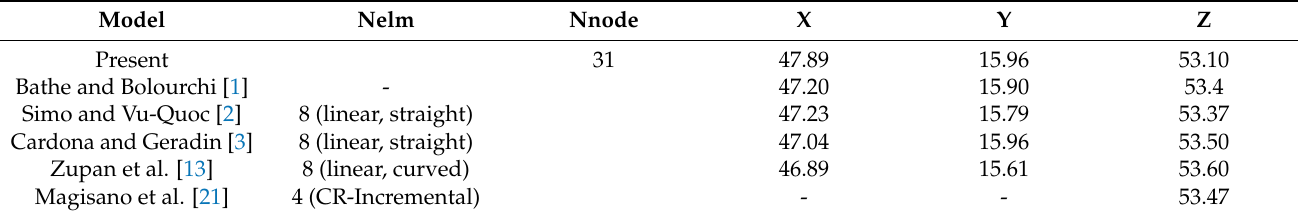
Figure 9. Load versus displacement curves of tip for the cantilever curved beam under an end force. Table 1. Free-end position of the cantilever 45-degree under out-of-plane force.